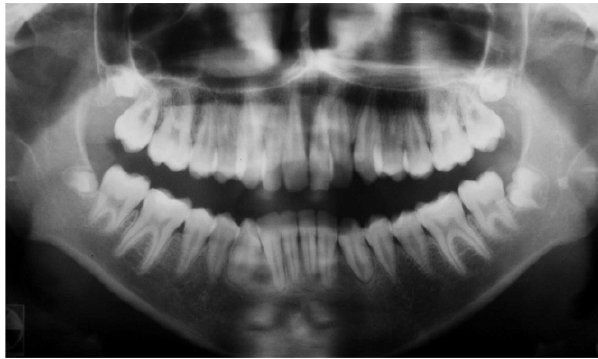
Figure 3 - Panoramic radiograph of a 6-year-old patient at diagnosis who was submitted to chemotherapy and 6,750 cGy irradiation. Note blunted and shortened V-shaped roots of the upper and lower premolars and